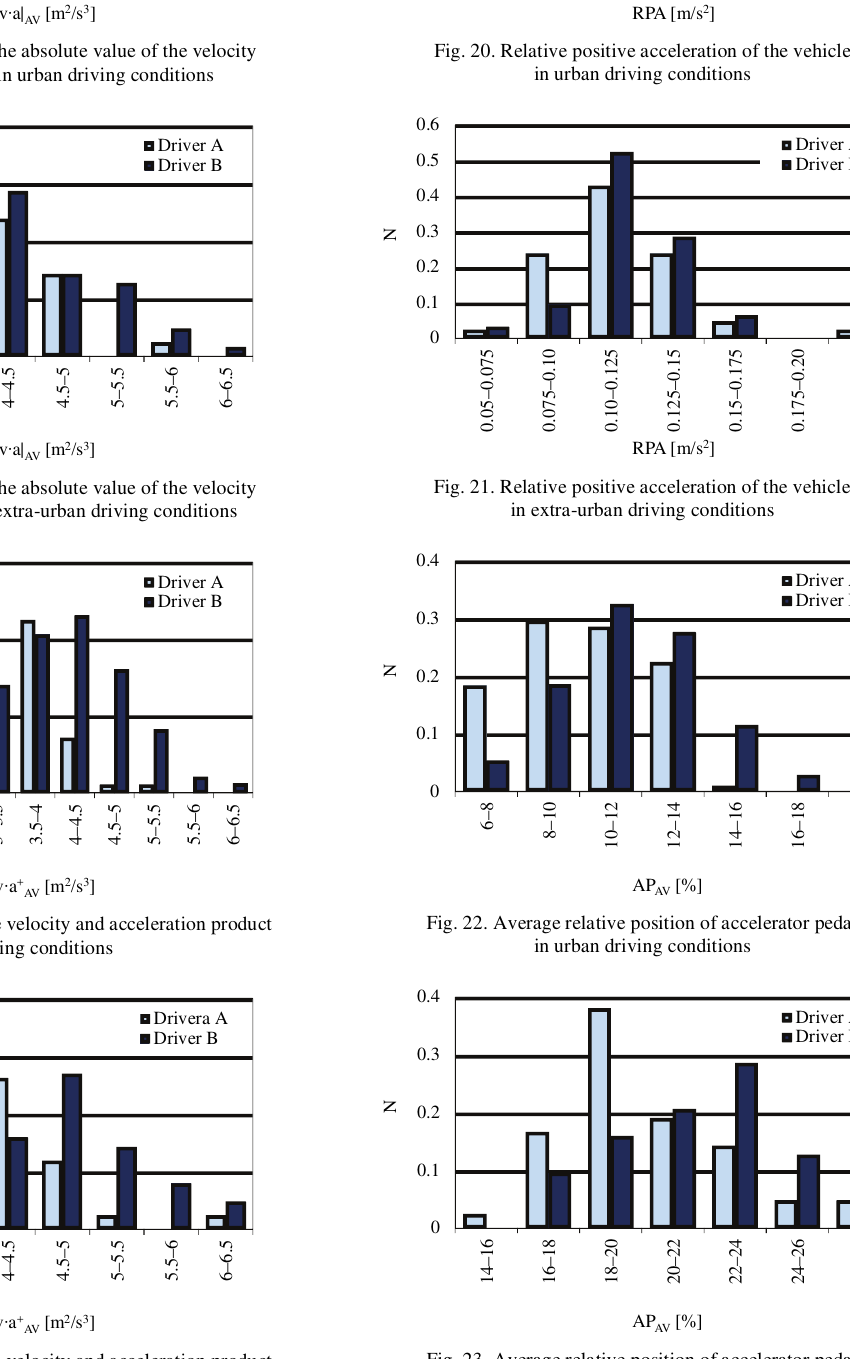
Fig. 19. The average value of the velocity and acceleration product in extra-urban driving conditions